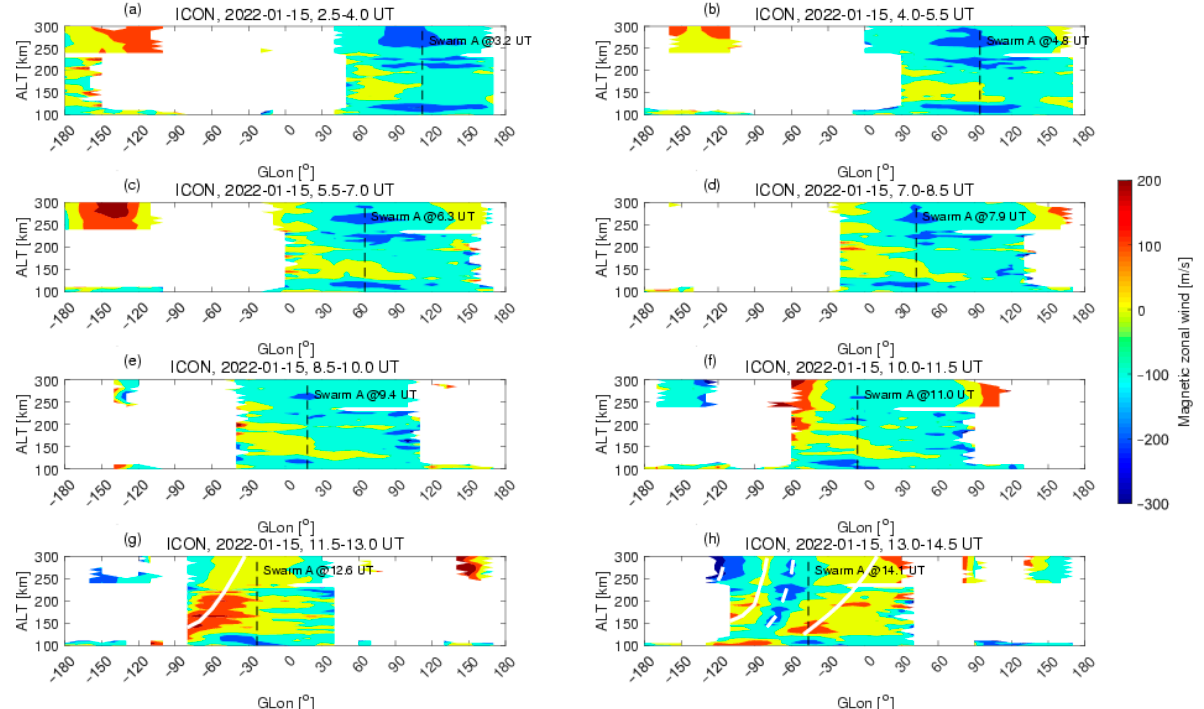
Figure 5. The magnetic zonal wind as observed by ICON is displayed as a function of the altitude and geographic longitude. Panels ( a – f ) are before the arrival of the volcanic eruption at Swarm longitudes, and panels ( g , h ) are after the arrival of the eruption at Swarm longitudes. The vertical dashed lines denote the longitude of Swarm A. Longitudinal wave structure with reversed polarities are as indicated by the solid and dashed white curves in panels ( g , h ).